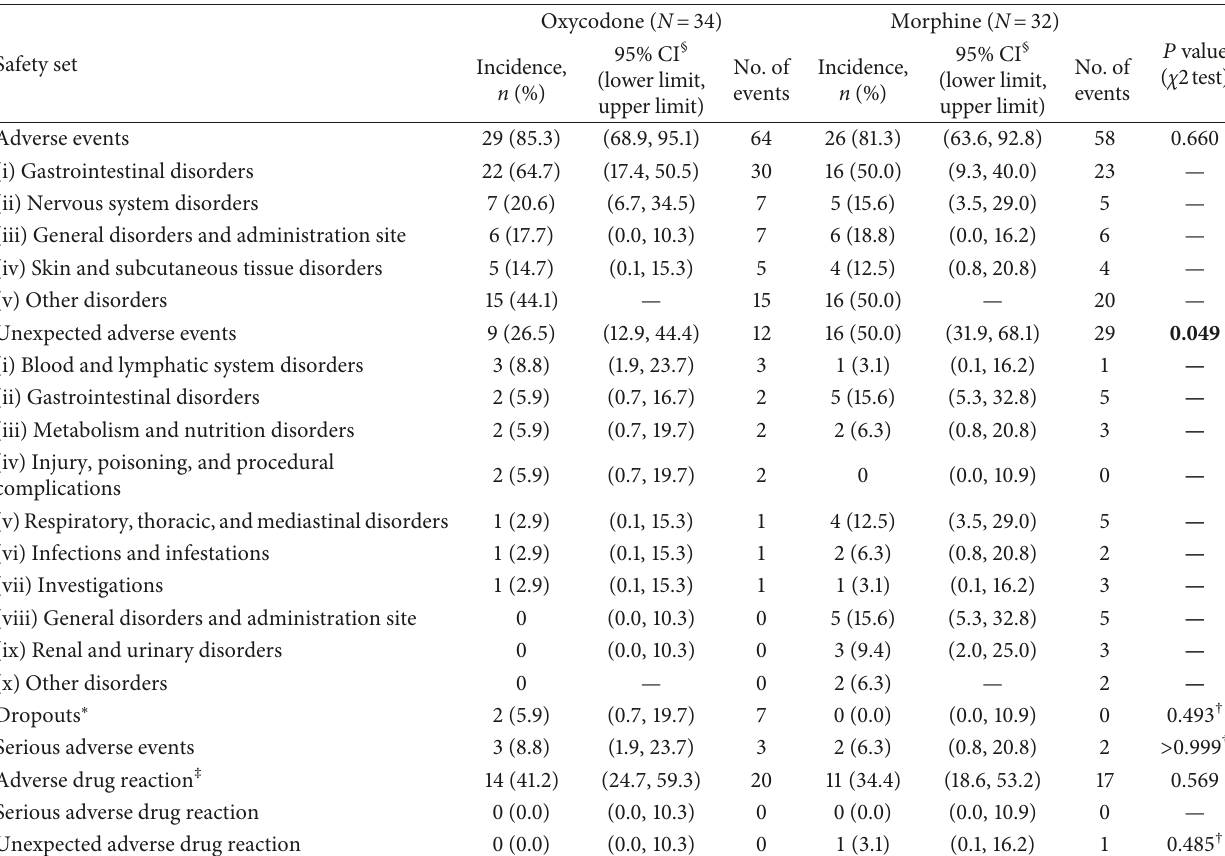
Table 3: Incidence of adverse